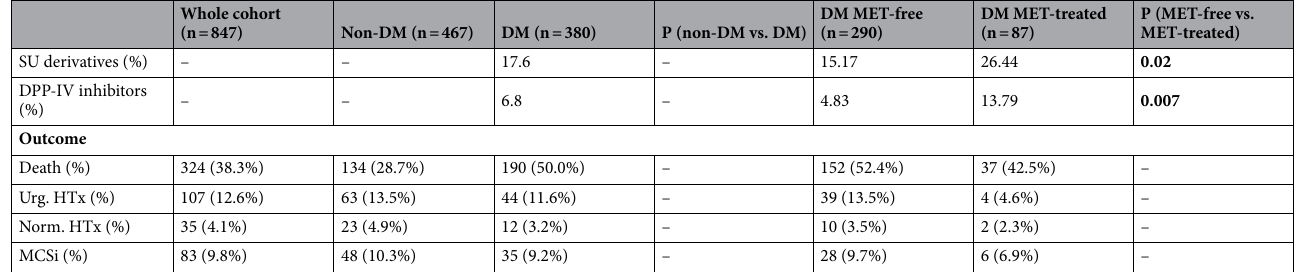
Table 1. Patients characteristics. Data are shown as mean ± SD or median with IQRs. & Available in 450 patients only. ∆ Available in 385 patients only. *Calculated for only 108 patients treated with insulin. Information about DM treatment was missing in 3 patients. Significant values are in